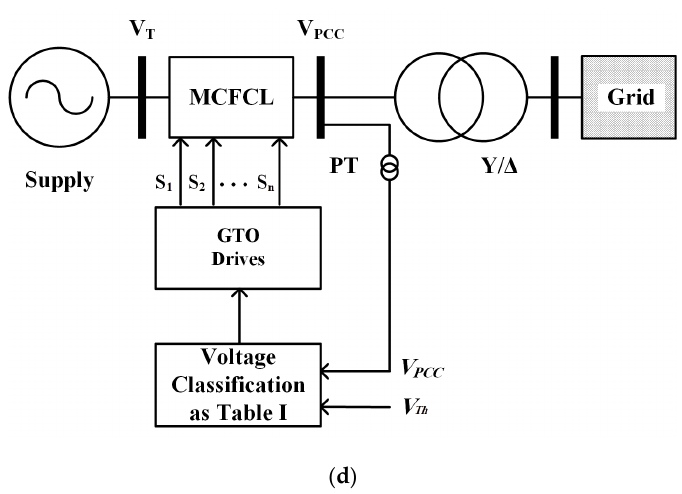
Figure 1. ( a ) Schematic diagram of the MCFCL, ( b ) MCFCL with three cells and resistors as limiting impedance, ( c ) Current path of the MCFCL for all steps according to Table 1, ( d ) MCFCL control system. Table 1. Switching